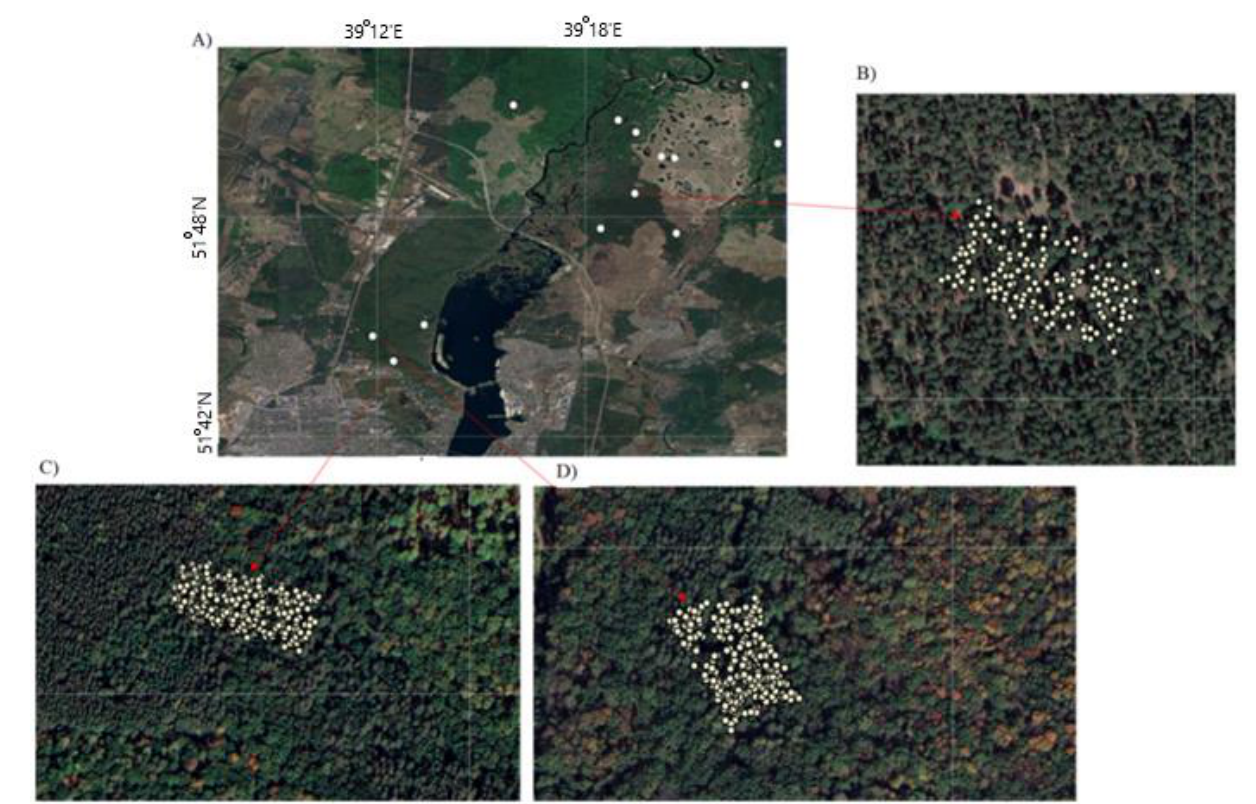
Figure 1. ( A ) Geographical location of study sites in the Suburban Forestry; ( B – D ) Placement of trees in the study areas within the polygon.